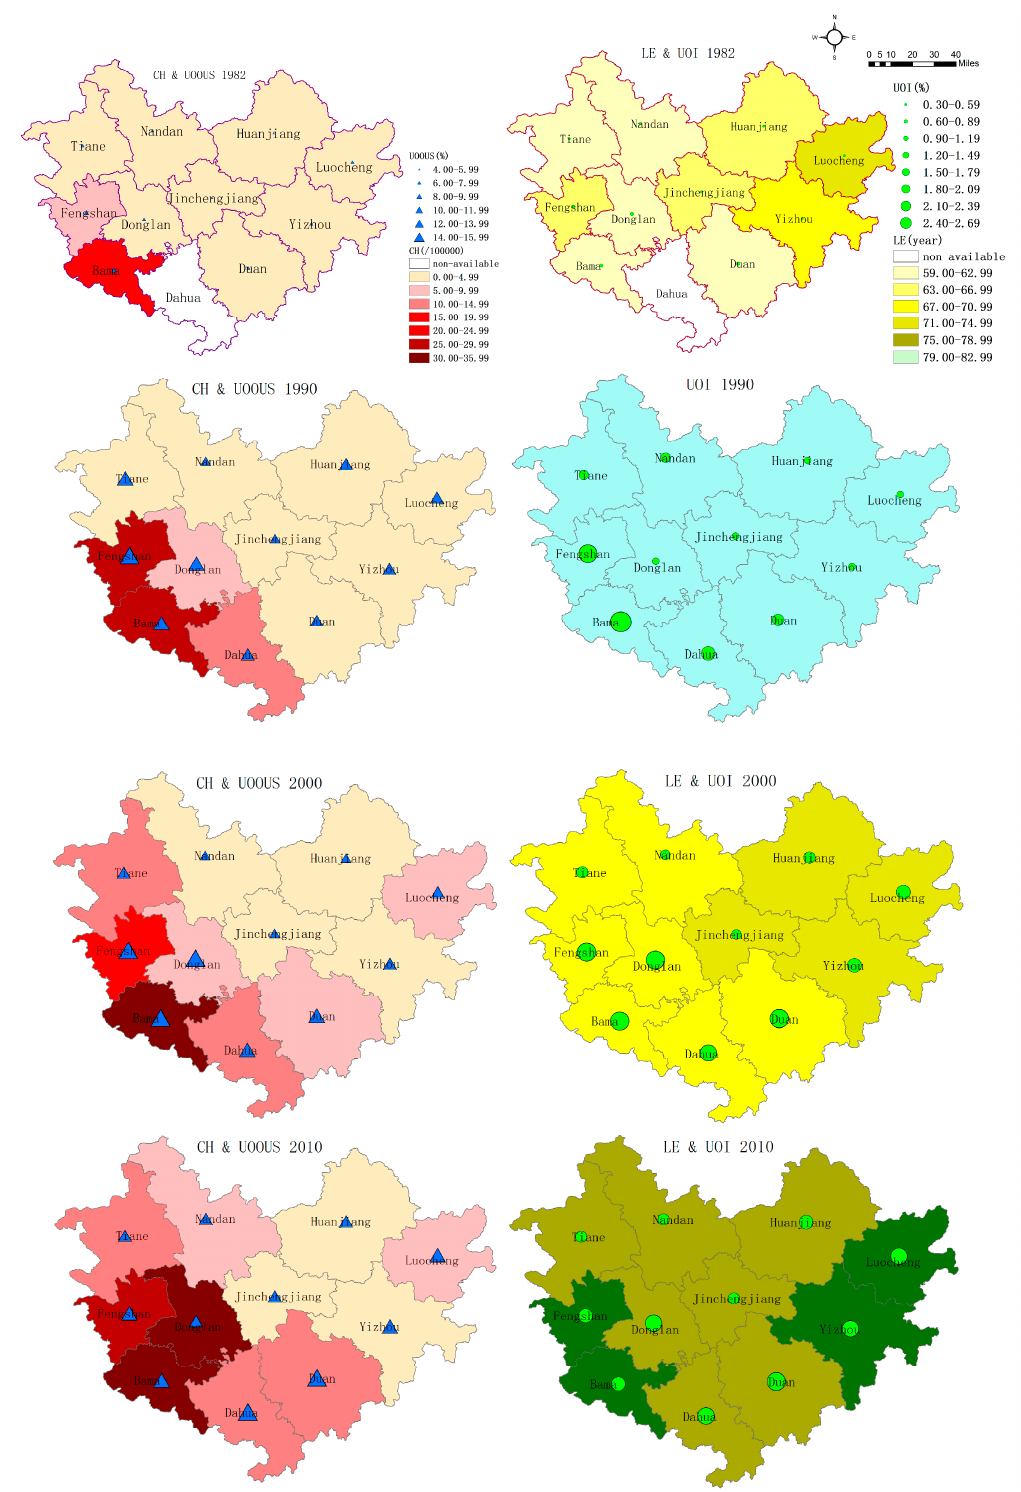
Figure 2. Spatial and temporal distribution of CH (the number of centenarians per one hundred thousand inhabitants), UOOUS (ultra ‐ octogenarian of the ultra ‐ sexagenarian; the ratio of the population above 80 years of age over the elderly population above 60 years of age), UOI (ultra ‐ octogenarian index; the percentage of the population aged at least 80 years) and LE (the life expectancy at birth) in Hechi city at county level (1982–2010).